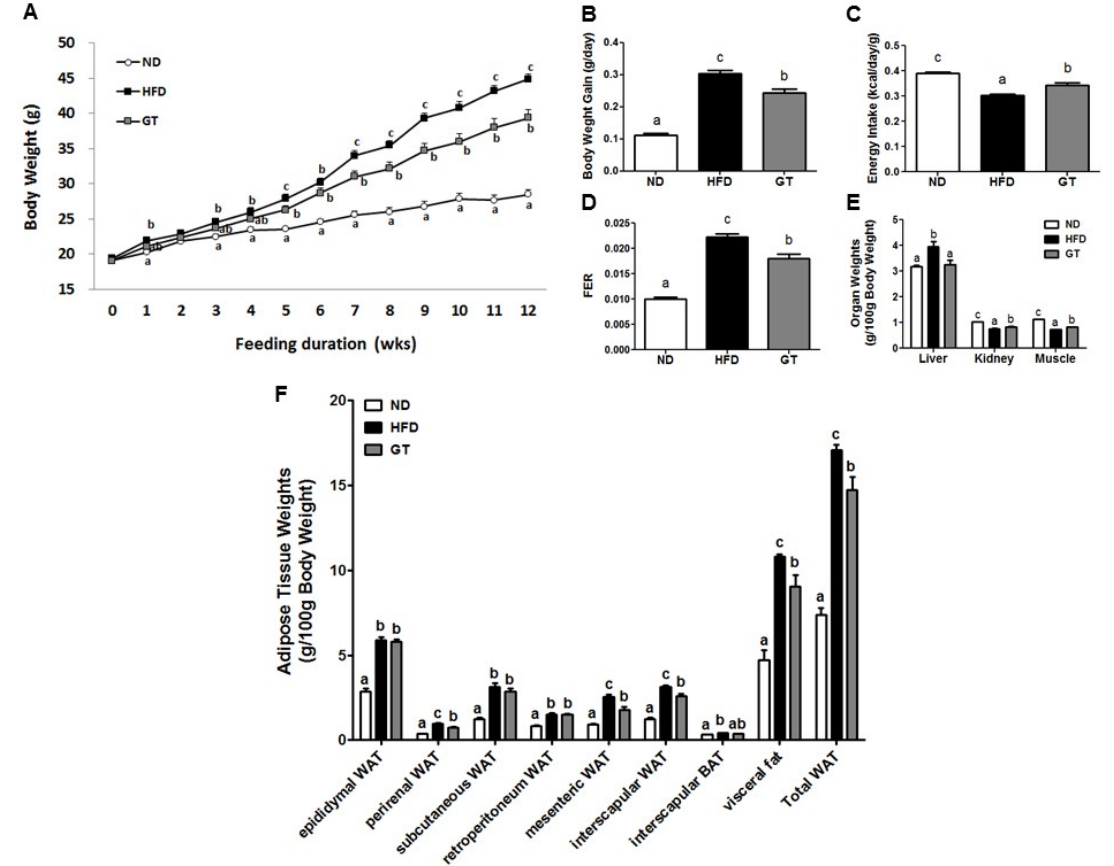
Figure 1. ( A ) Changes in body weight over 12 weeks; ( B ) body weight gain; ( C ) differences in energy intake; ( D ) food efficiency ratio; ( E ) organ weight; and ( F ) adipose tissue (AT) weights in diet ‐ induced obese C57BL/6J mice treated with green tea extract for 12 weeks. The data are shown as mean ± standard error of the mean. a–c Mean values not sharing a common superscript were significantly different among the groups ( p < 0.05). ND, normal diet, AIN-93G; HFD, high-fat diet, 60% kcal from fat; GT, green tea extract (0.25%, w / w ). FER, Food efficiency ratio = body weight gain/energy intake per day. Energy intake (kcal/day/g) = food intake (g/day) × calories (kcal/g) × body weight (g). The energy intake was normalized by mouse body weight.